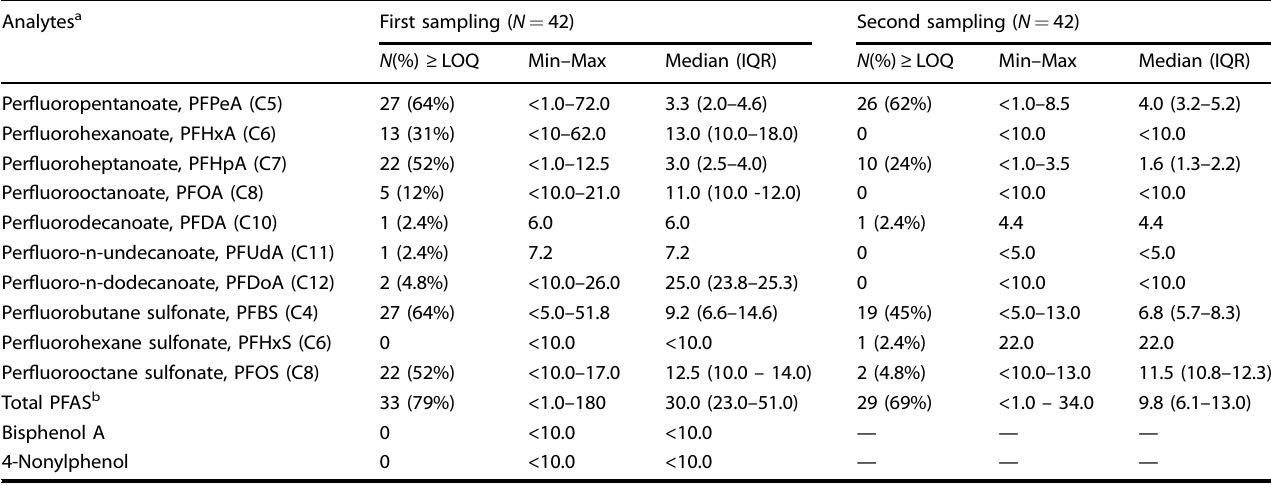
Table 1. Number (%) of samples above the limit of quanti fi cation ( ≥ LOQ), and concentrations (ng/L) of target compounds in un fi ltered tap water samples collected in 42 locations in Barcelona, Spain, in repeated sampling campaigns (August – October 2020, and May 2021). Analytes